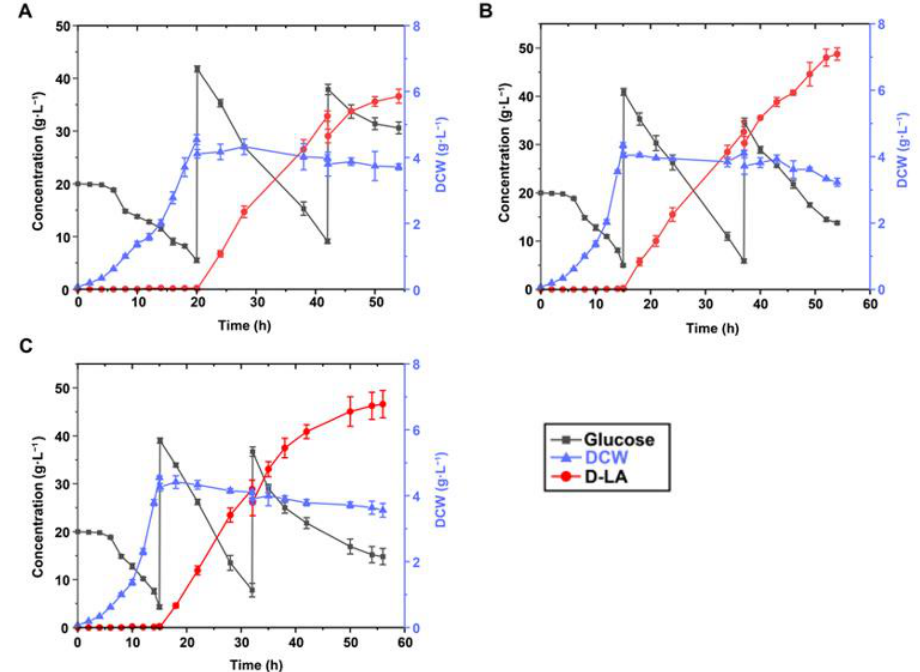
Figure 4. Effect of IPTG addition on D-LA synthesis during growth to different growth stages. ( A ) Addition of IPTG at LLP (late lag phase) had a shorter fermentation cycle but lower D-LA synthesis. ( B ) Addition of IPTG at PEP (pre-exponential) had the maximal amount of D-LA synthesis. ( C ) Addition of IPTG at MPEP (mid pre-exponential period) had D-LA synthesis close to that at PEP period, but with slightly longer fermentation